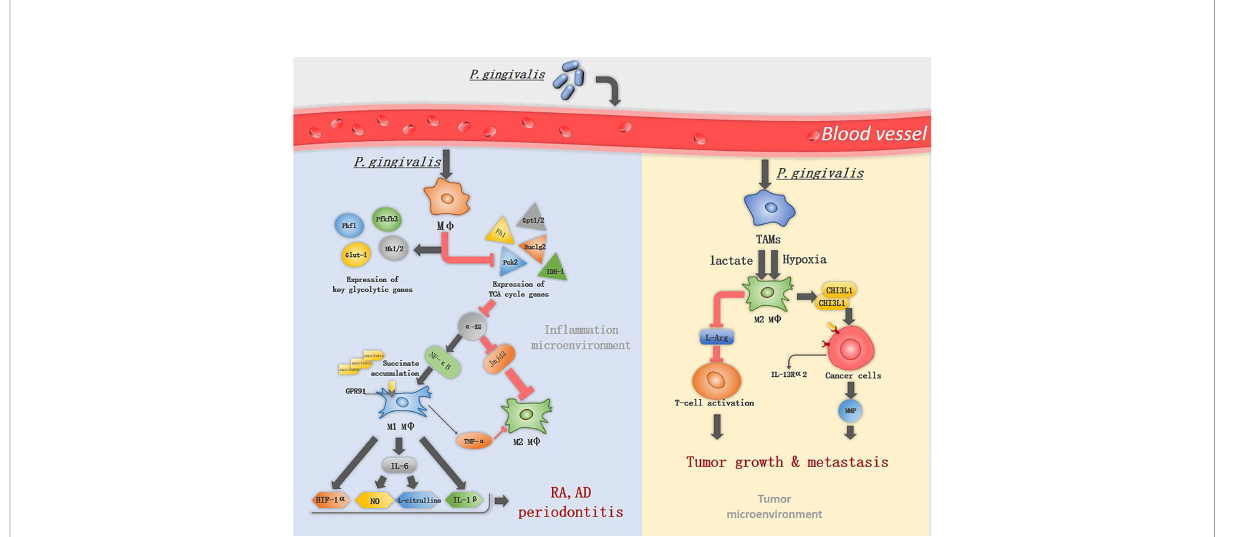
FIGURE 1 The mechanism of P. gingivalis in inducing macrophage polarization. P. gingivalis interacts with macrophages and increases the expression of key glycolytic genes, while inhibits the expression of TCA associated genes. a -KG is an important immunomodulator of M2 macrophage activation and can be suppressed by P. gingivalis through down-regulation of Idh1/2 and Gpt1/2, therefor induce classical M1 macrophage activation. M1 macrophages upregulate the expression of GPR91 and produce TNF- a , IL-1 b , IL-6, NO, L-citrulline and HIF-1 a , promoting the progress of RA and periodontitis. In TME, lactate and hypoxia promote TAM polarization into M2-like macrophages, which deplete L-Arg resulting in suppression of cytotoxic T-cell activation. M2 macrophages promote tumor metastasis by secreting CHI3L1 protein and MMPs, the CHI3L1 protein interacts with IL-13R a 2 expressing on the cancer cells, leading to upregulation of